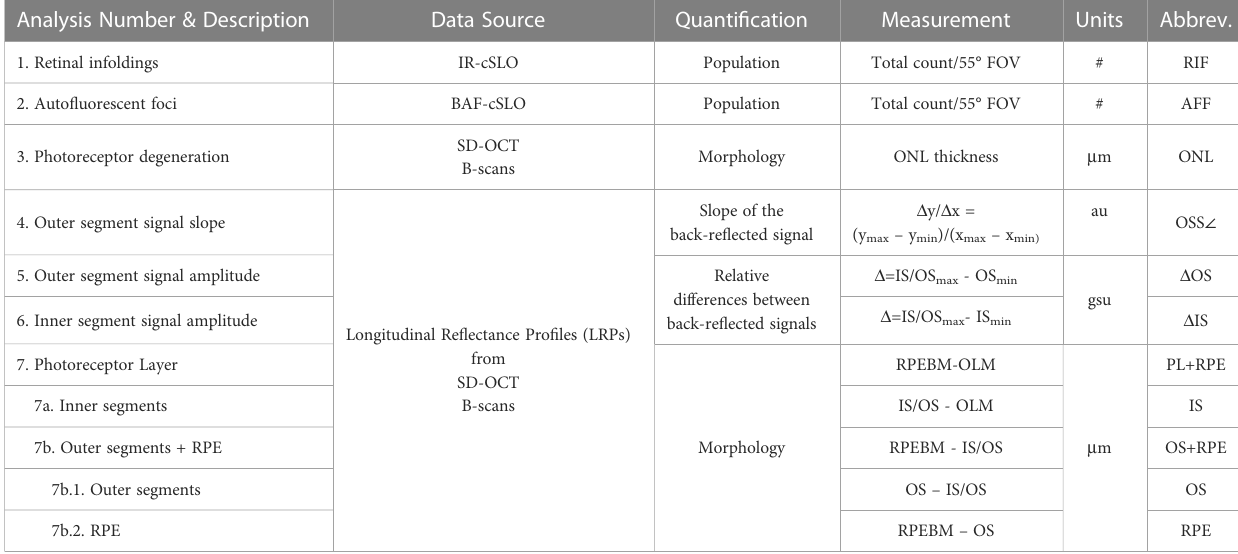
TABLE 2 Data analyses performed on cSLO and SD-OCT images (Units: #, total number counted within a 55°cSLO FOV; m m, thickness in micrometers; au, arbitrary units; gsu, grayscale units). Analysis Number &